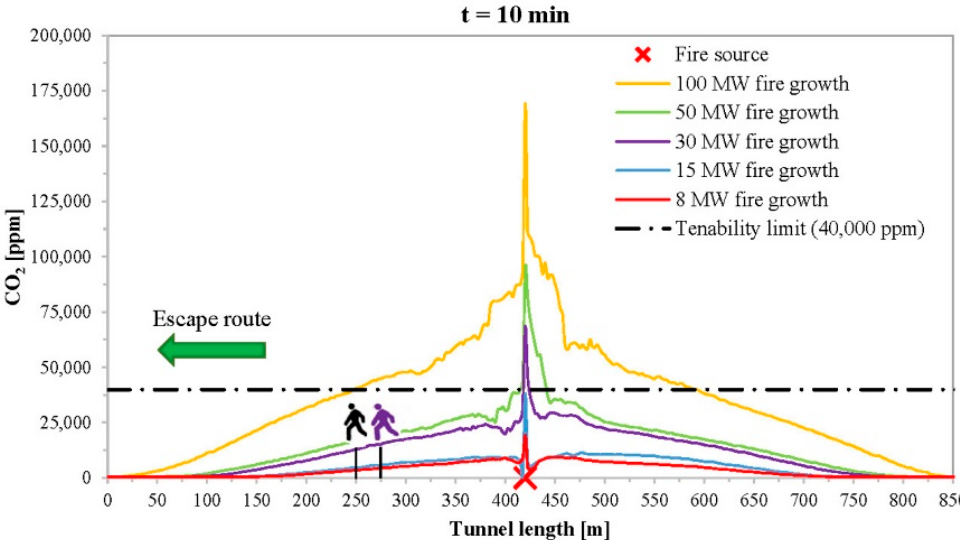
Figure 8. Profiles of longitudinal CO 2 concentration at a height of 2 m along the escape route on the road carriageway after 10 min from the fire’s start when the burning vehicle is at 420 m from portal A.